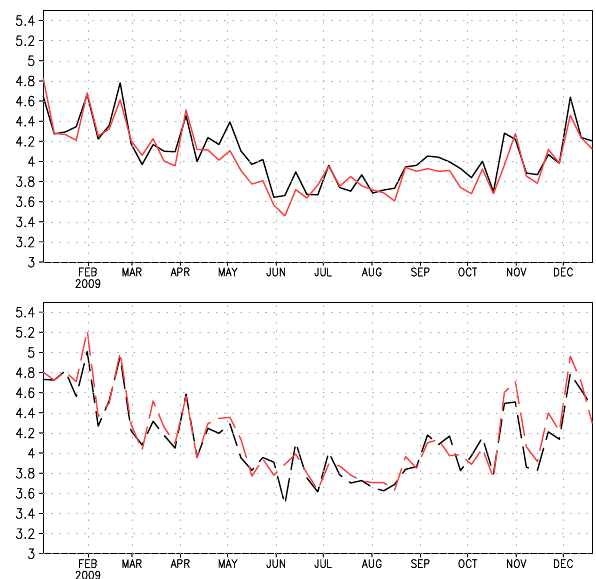
Fig. 4. Top panel shows the RMS of SLA residuals (cm) in experi- ments ATPR1 (continuous red line) and CONT1 (continuous black line) during 2009, and the bottom panel shows the RMS of SLA residuals (cm) in experiments ATPR2 (dashed red line) and CONT2 (dashed black line) during 2009. The RMS of SLA residuals is cal- culated once a